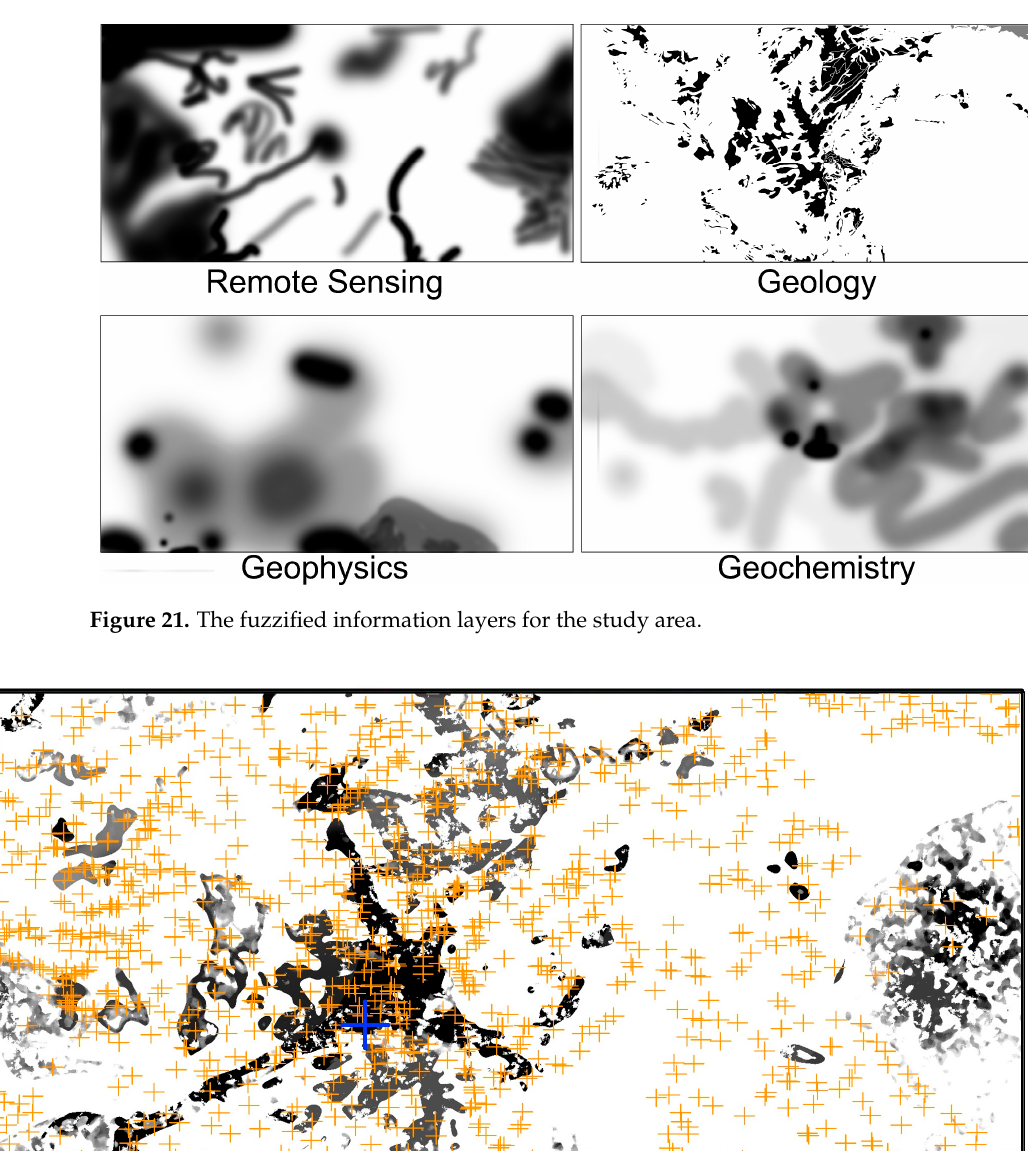
Figure 23. Polished sections of mineralogical samples from checked Points. ( A ) Malachite with Fe hydroxides in silica gangue; ( B ) Pyrite and Fe oxides, whose marginal parts have been replaced by limonite and goethite; ( C ) Fe hydroxides and malachite formed secondary along the fractures; ( D )